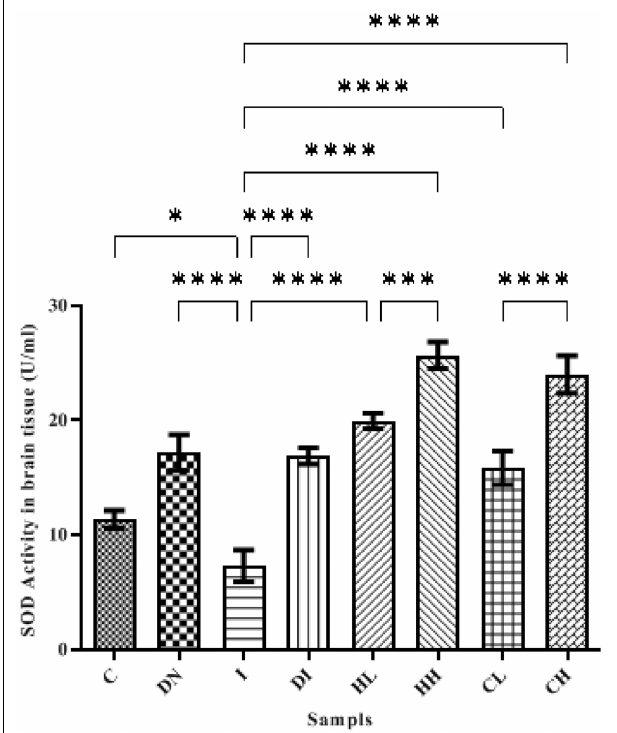
FIGURE 4 | SOD activity in the brain tissue of the treated mice, Group C, control group: Normal saline-receiving group; Group DN, normal saline and deferoxamine-receiving group; Group I, iron dextran and normal saline-receiving group; Group DI, iron dextran and deferoxamine-receiving group; Group HL, low dose hesperidin-receiving group; Group HH, high dose hesperidin-receiving group; Group CL, low dose coumarin-receiving group; and Group CH, high dose coumarin-receiving group (Mean ± SD; ∗ p ≤ 0.05, ∗∗∗ p ≤ 0.001, ∗∗∗∗ p ≤ 0.0001).